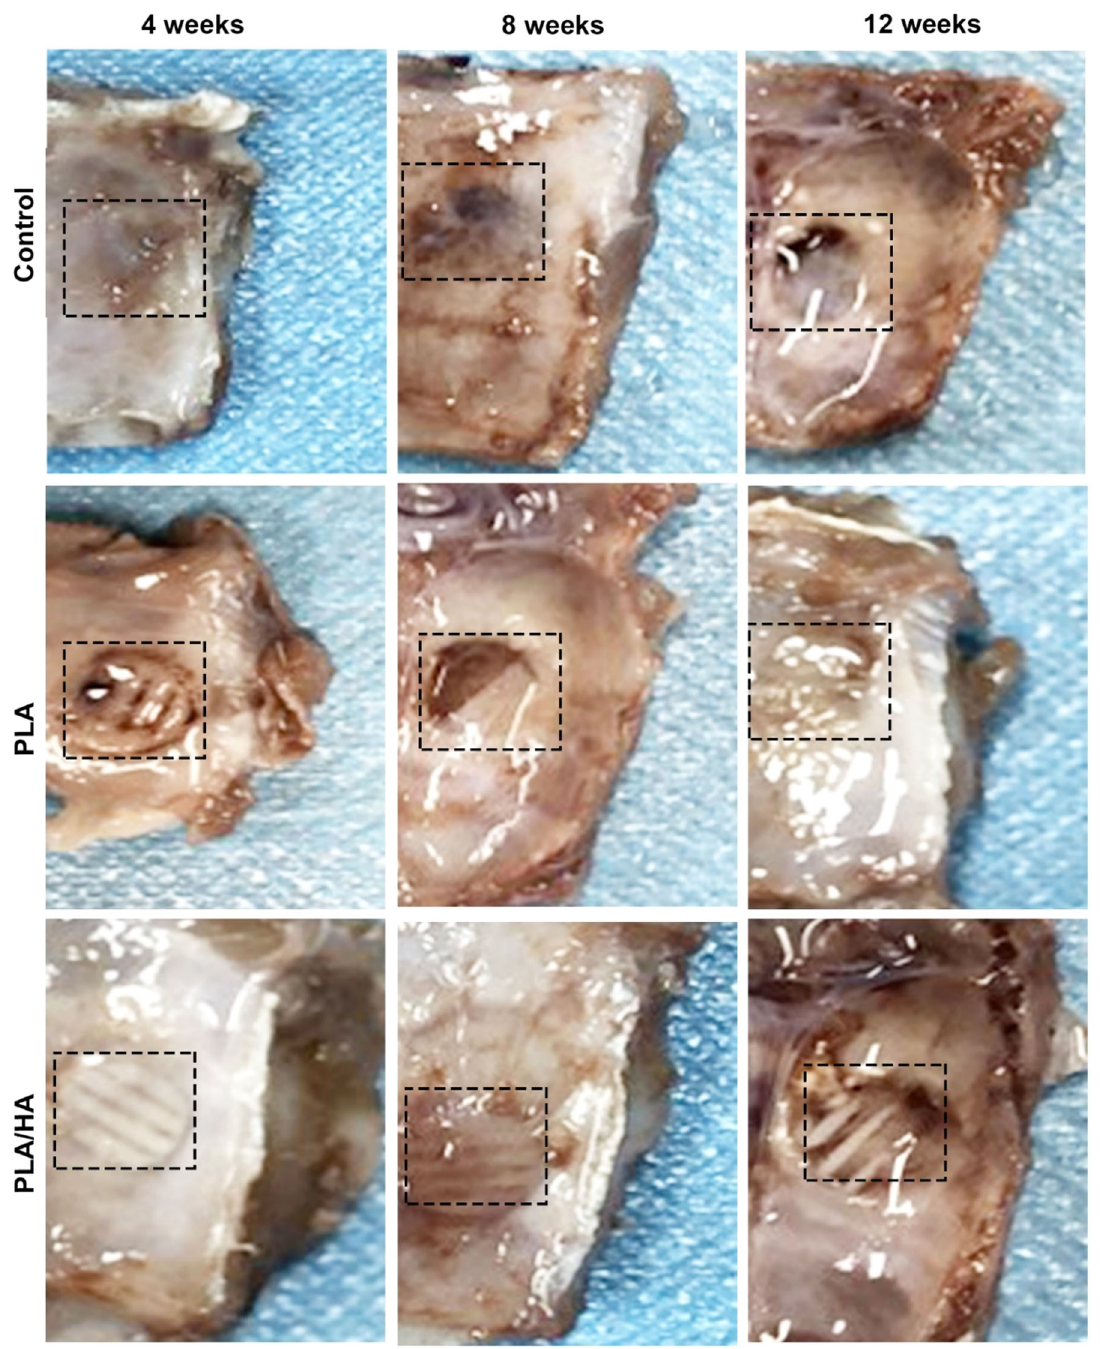
Fig. 6 Photographs of skull defects in rats that received no treatment (control), PLA with USCs, and PLA/HA with USCs at each time point (4, 8, and 12 weeks after